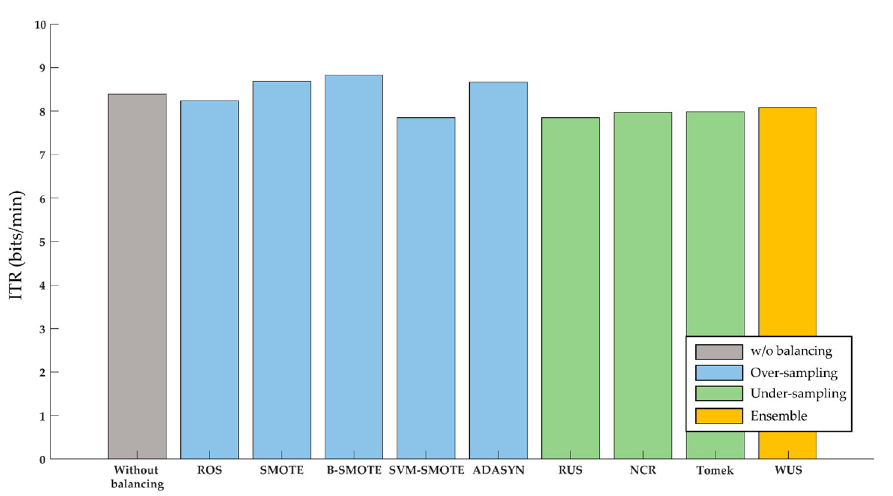
Figure 5. Information transfer rate (ITR) of BCIs over all three home appliances without balancing as well as with various sampling techniques.